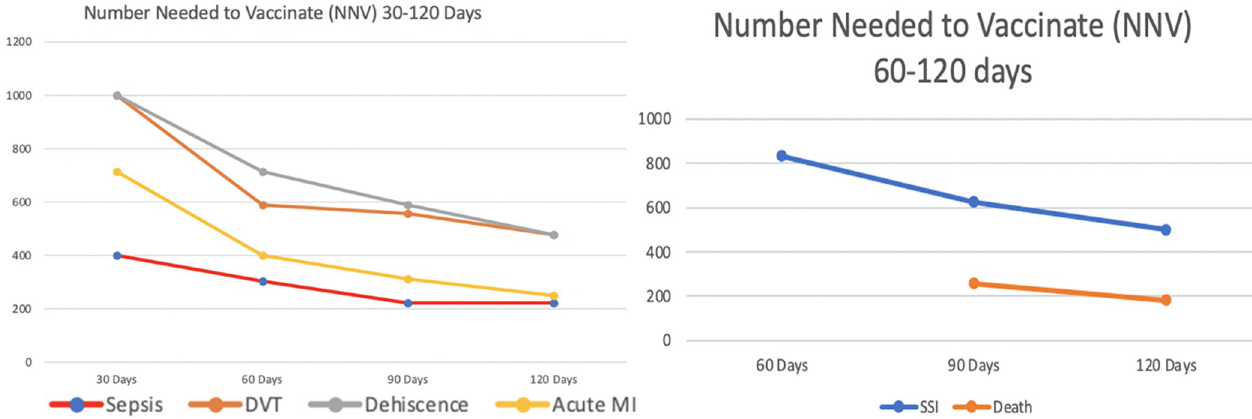
Fig 3. Number needed to vaccinate with influenza immunization to prevent one of the following post-operative adverse outcomes within 30–120 days (Fig 3a) and 60–120 days (Fig 3b) of surgery in this population.